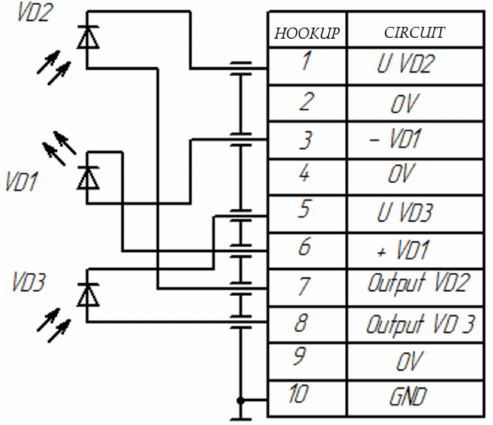
Figure 8. Functional diagram of the receiving and transmitting module RTM. VD1—LED; VD2,